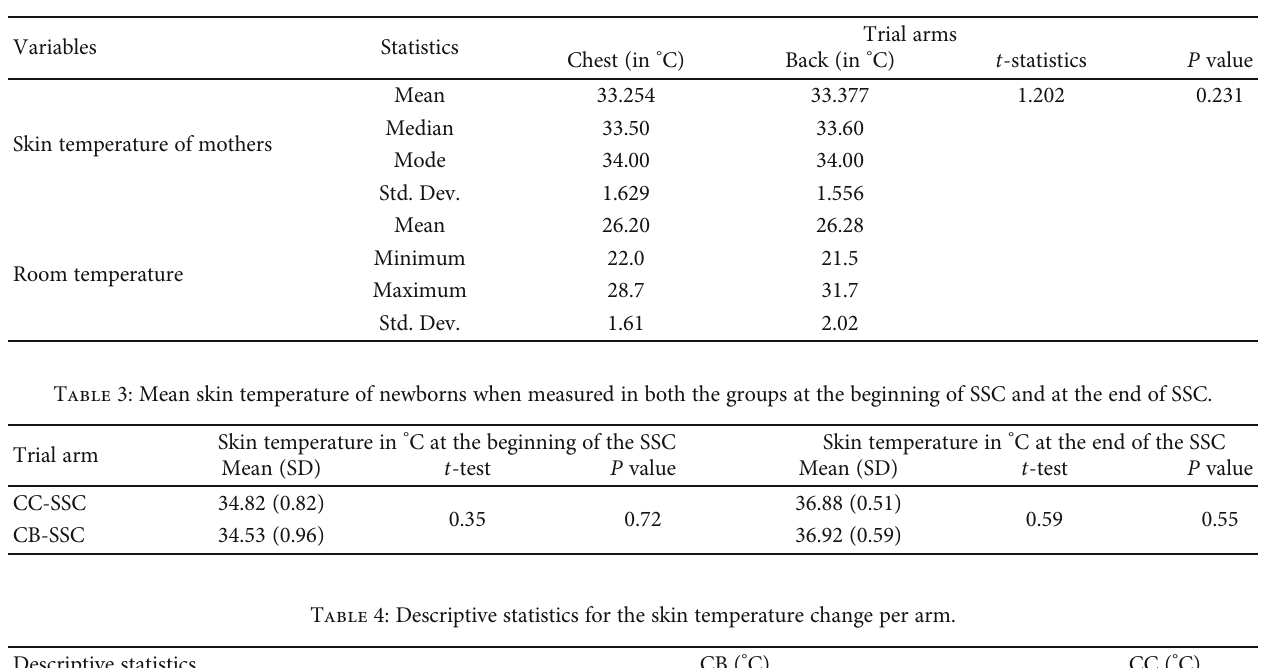
Table 2: Skin temperature of the chest and the back of the mothers and room temperature.